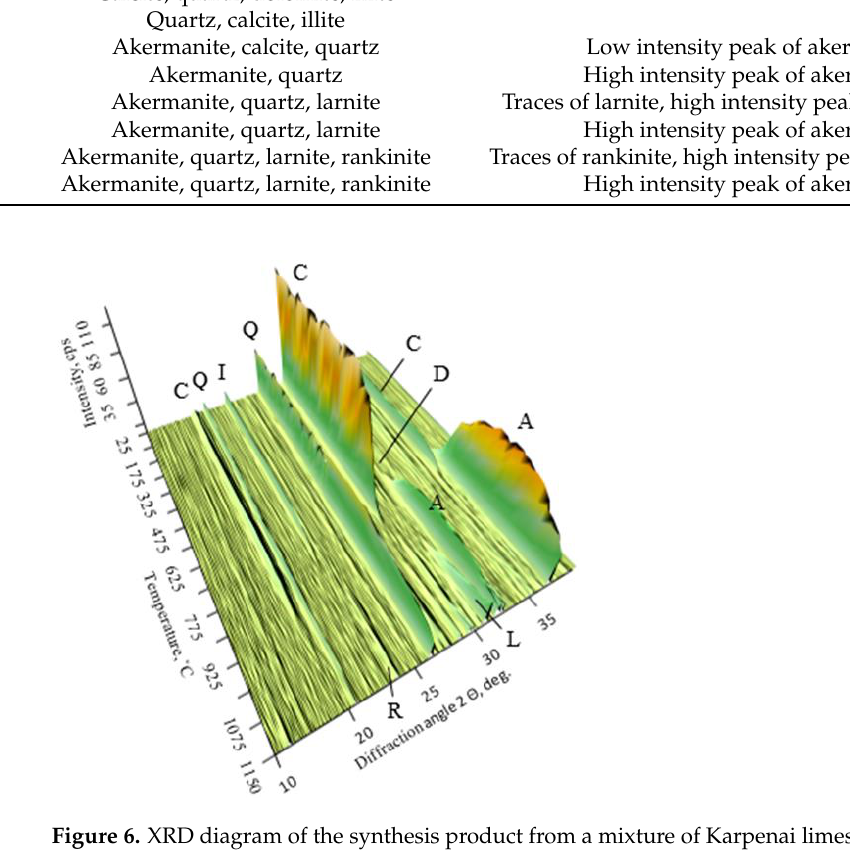
Figure 5. Mineralogical ( a ) and granulometric ( b ) composition of OPC clinker, where 1—cumulative volume, 2—differential volume. Indexes: C 3 S—alite, C 2 S—belite, C 3 A—calcium aluminum oxide, C 3 Ana—sodium calcium aluminum oxide, C 4 AF—calcium aluminum iron oxide, MgO—periclase. In order to preliminarily determine the optimal calcination conditions for this mix- ture, high-temperature X-ray diffraction analysis was performed in the temperature range of 25–1150 °C. The data are presented in Table 2 and in Figure 6. Table 2. The compounds, which were identified in the synthesis product, from a mixture of Karpenai limestone and Saltiskiai clay (CaO/SiO 2 = 1.5) in 25–1150 °C temperature range.